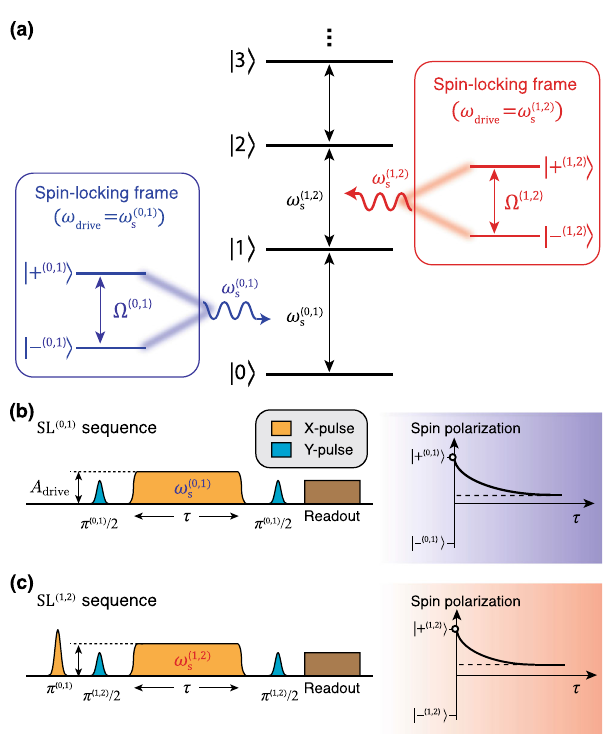
Fig. 1 Spin-locking noise spectroscopy in a multi-level sensor. a A transition between the ( j − 1)th and j th level of a multi-level system is driven resonantly to form the j th spin-locking basis (dressed states) (cid:7) (cid:8) (cid:7) { þ ð j (cid:2) 1 ; j Þ , j(cid:2) ð j (cid:2) 1 ; j Þ i } which are separated by the Rabi frequency Ω ( j − 1, j ) . The (cid:7) (cid:8) (cid:7) two-level system formed by the basis { þ ð j (cid:2) 1 ; j Þ , j(cid:2) ð j (cid:2) 1 ; j Þ i } acts as the j th spin-locked noise spectrometer. b , c Spin-locking (SL) sequences used to (cid:7) (cid:7) (cid:8) (cid:8) (cid:7) (cid:7) measure the relaxation of spin polarization þ ð 0 ; 1 Þ and þ ð 1 ; 2 Þ as a function of the spin-locking duration τ , spectrometer, respectively. The longitudinal noise in the lab frame (Eq. (1)) for a multi-level system leads to both transverse and longitudinal noise in the spin-locking frame. As a result, the longitudinal noise operator B ( j ) ( t ) in the lab frame is transformed into the spin-locking frame as a transverse noise operator ; j Þ ~ ð t Þ , which leads to longitudinal relaxation, and the B ð j (cid:2) 1 ? ; j Þ ~ longitudinal noise operator B ð j (cid:2) 1 k